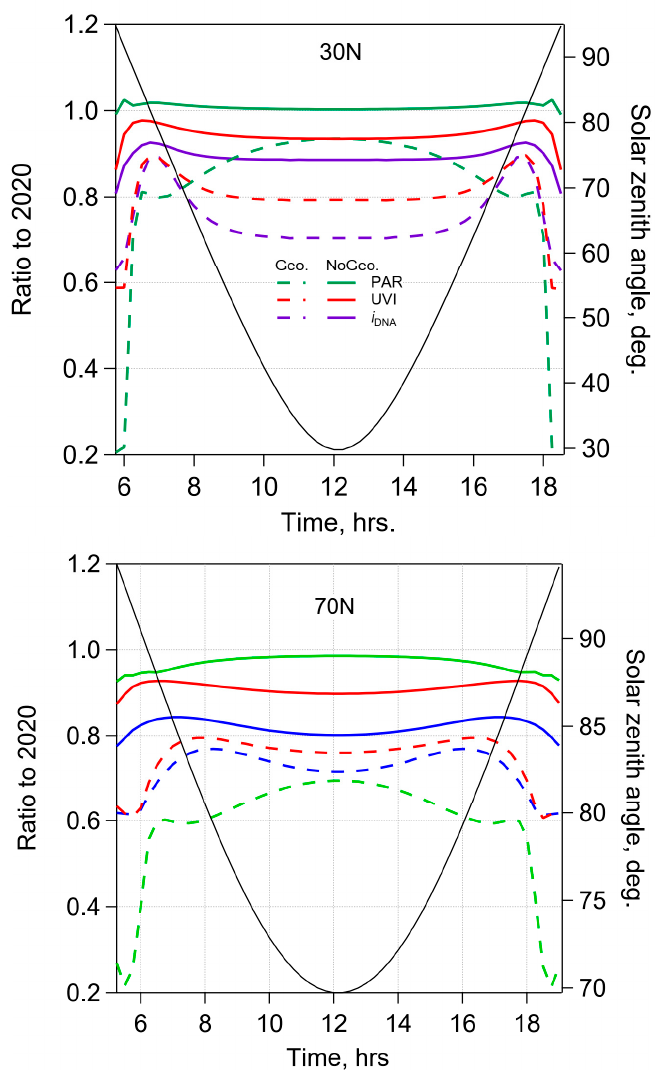
Figure 4. Changes in biologically active radiation at the Earth’s surface, in March 2080 relative to March 2020, for DNA-weighted irradiance i DNA (blue), UV index (UVI) (red), and photosynthetically active radiation PAR (green), without geoengineering (solid curves) and with geoengineering (dashed curves). The black curve and right axis refer to solar zenith angle.